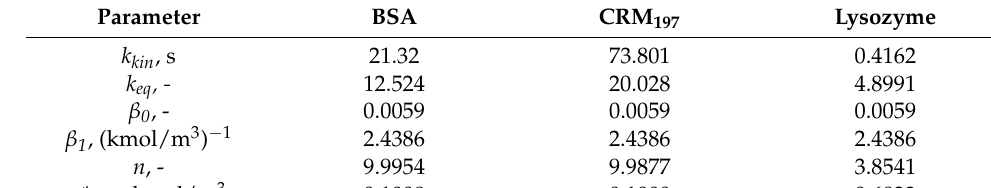
Table 9. Parameters values for Wang et al. model estimated by DSPX.